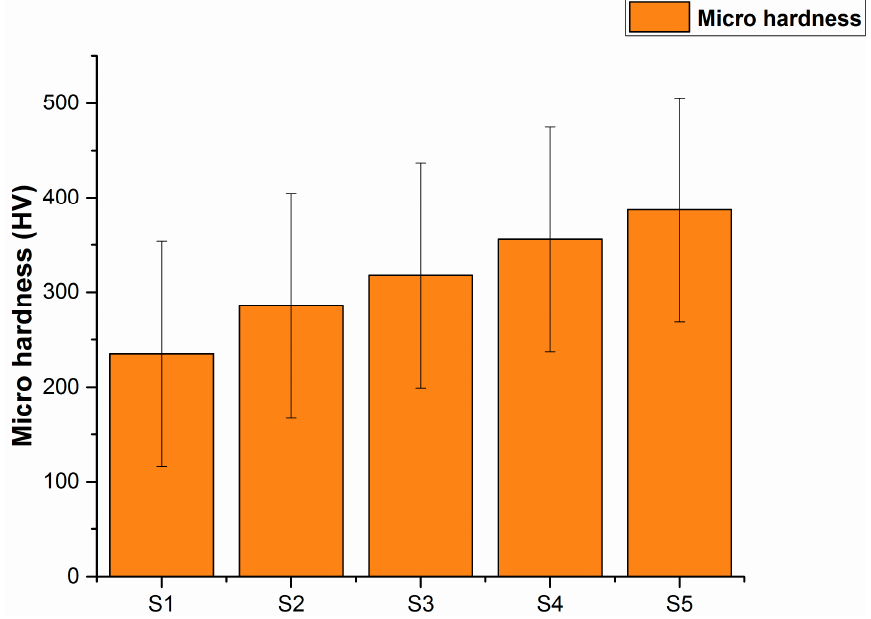
Figure 4. Micro hardness of all samples.